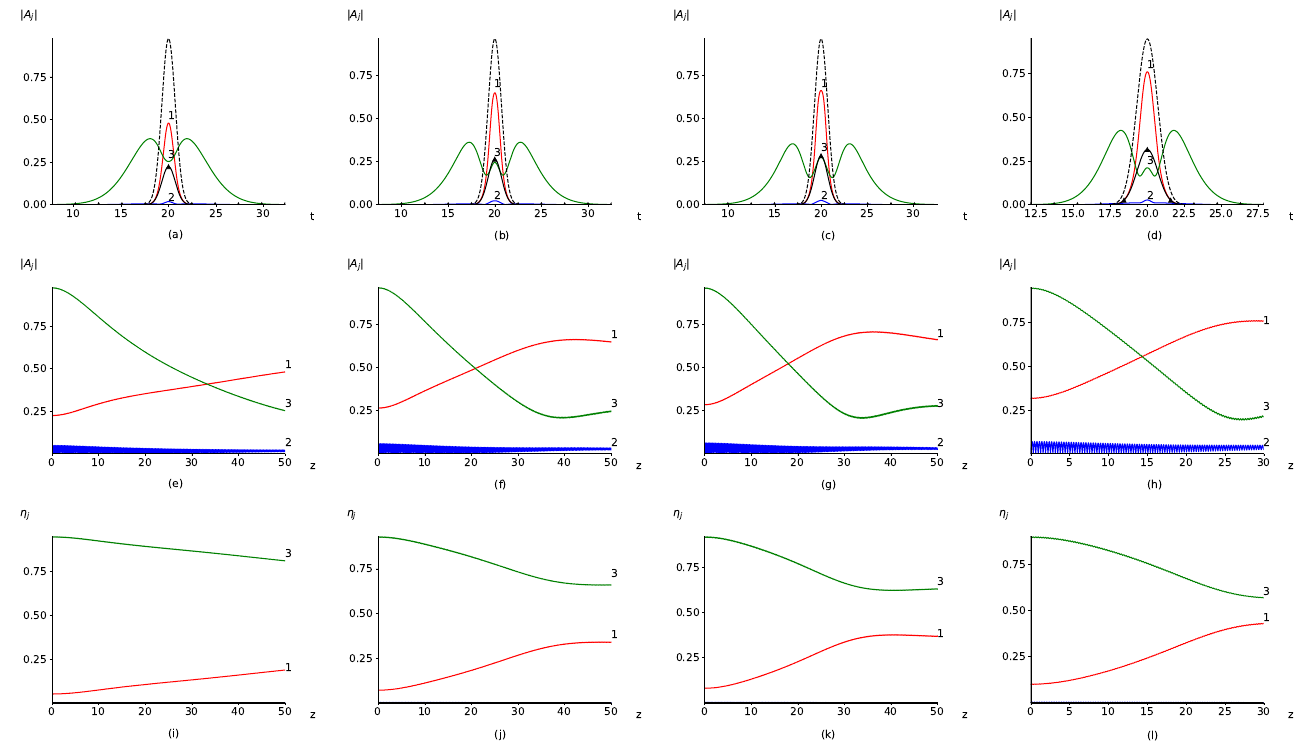
Figure 3. Pulse shapes in the section z = 50 ( a – c ), 30 ( d ); pulse intensity evolution at the centers ( e – h ), and the frequency conversion efficiency evolution ( i – l ) along the z -coordinate computed for | A | 2 = 0.05 ( a , e , i ), 0.07 ( b , f , j ), 0.08 ( c , g , k ), 0.1 ( d , h , l 10